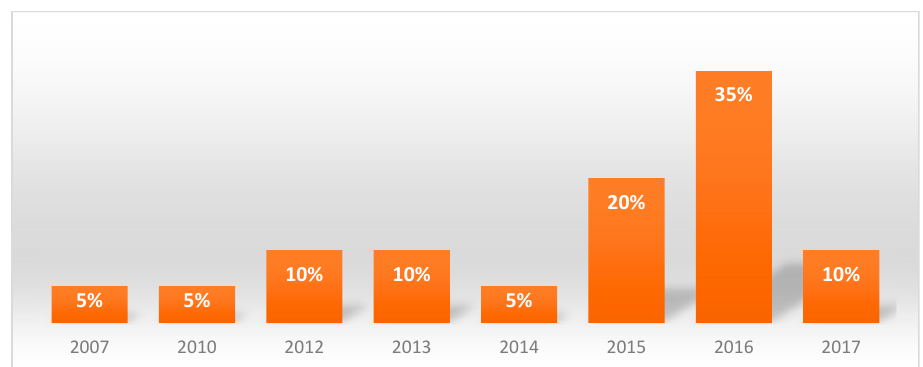
Figure 1. Areas of lesions’ presentation.